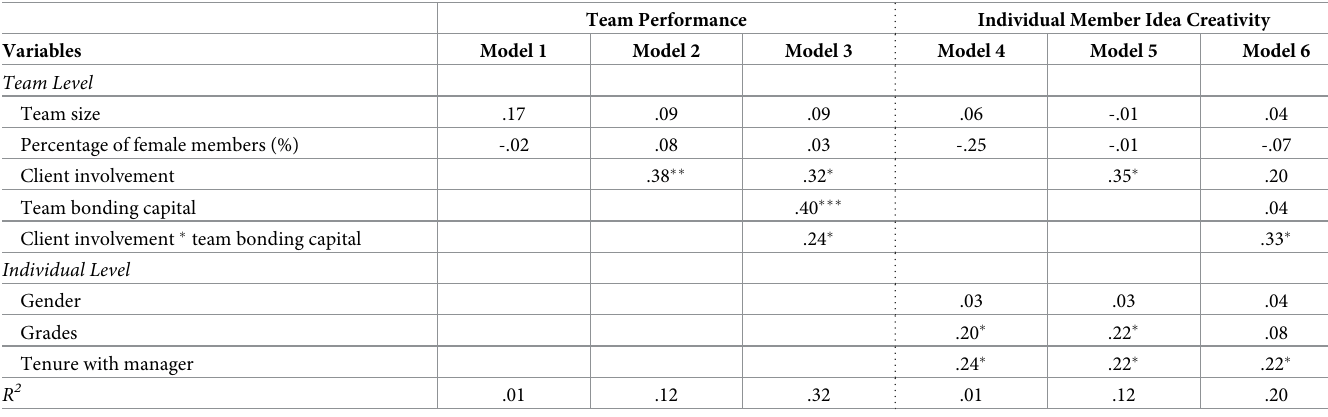
Table 3. Results of